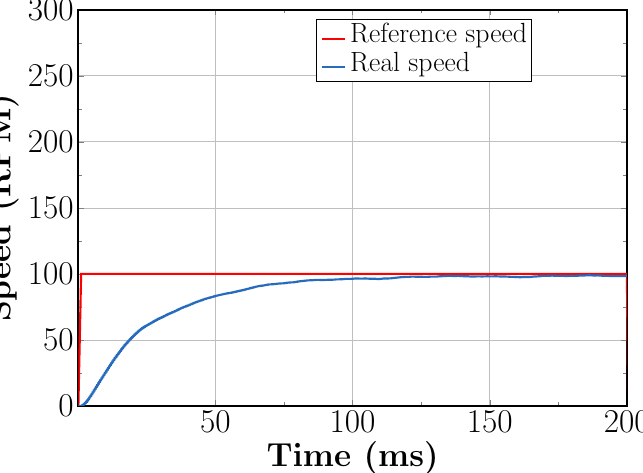
Figure 21. Sensorless speed control for 100 RPM, speed reference and real speed of the machine.